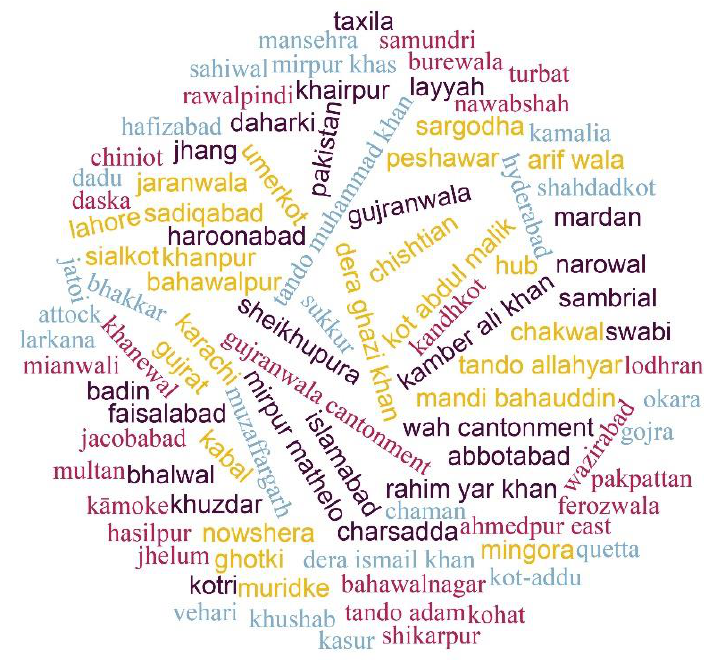
Figure 2. Names of places in